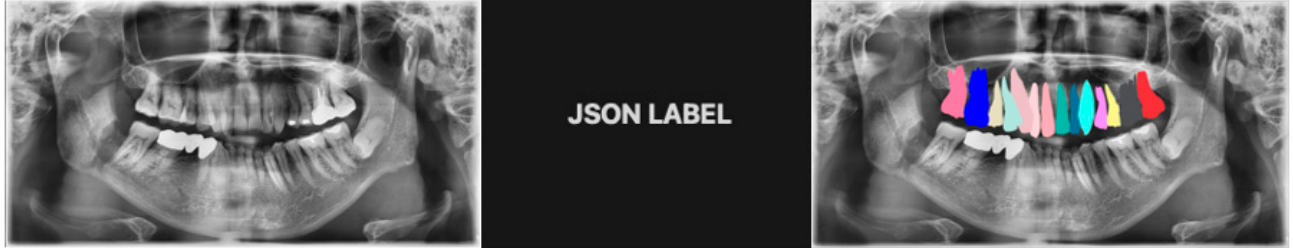
Figure 2. Identification of teeth through a combination of raw data and JSON label.